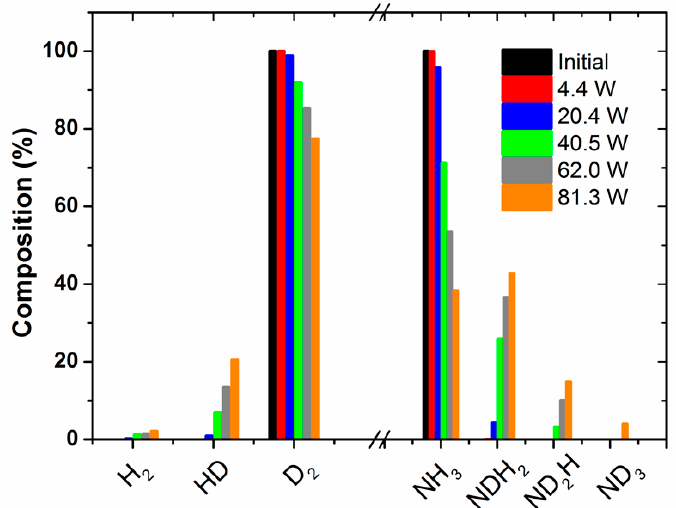
Figure 2. Percentage of isotopic labelled species detected for Reaction (1) as a function of plasma power.